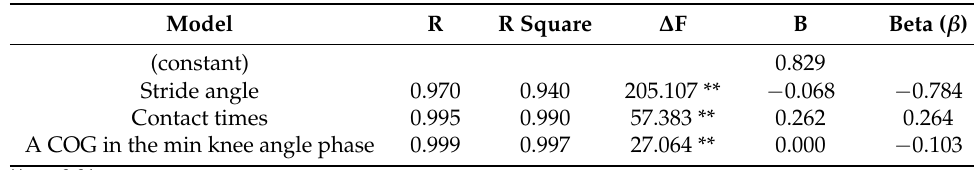
Table 5. Multiple linear regressions for